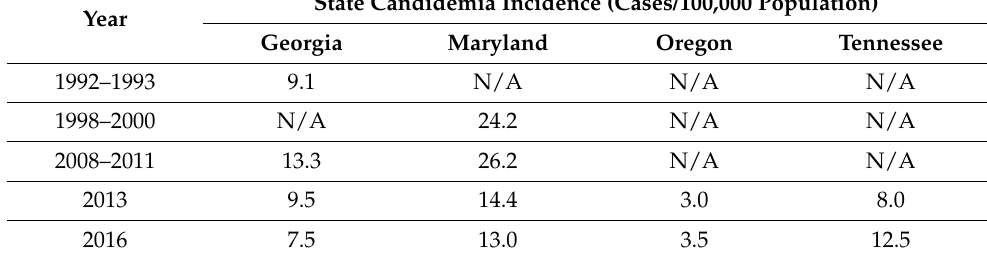
Table 1. Overall candidemia population-based incidence rates expressed as the number of cases per 100,000 population across 4 metropolitan sites in four US states from 1992 to